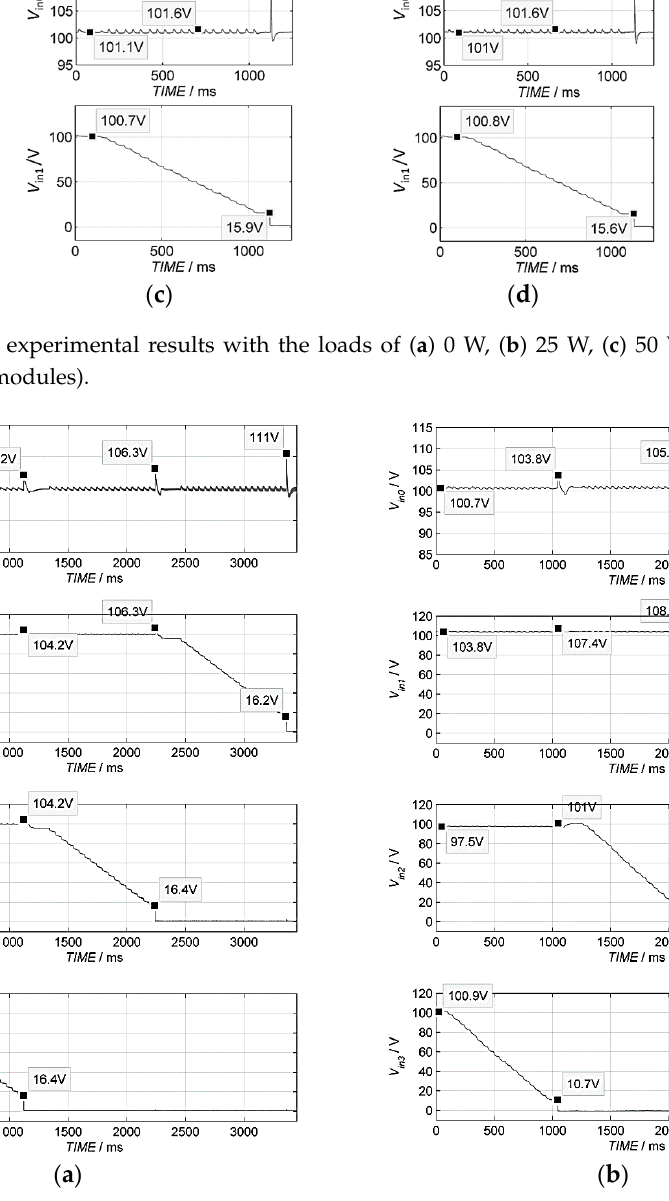
Figure 14. The ( a ) simulated and ( b ) experimental waveforms of the input voltages of each module with ASB (4 modules).